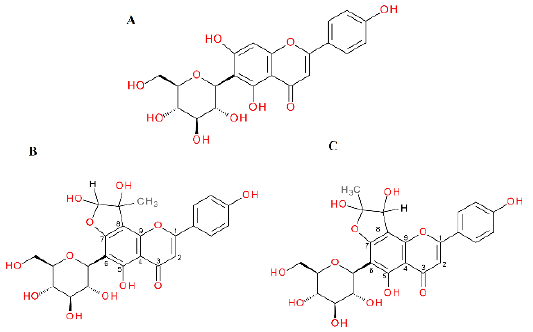
Figure 12. Proposals for chemical structures of adducts formed in the reaction of isovitexin with methylglyoxal after 1 h of incubation in pH 7.4 phosphate buffer solution at 37 °C; ( A ), isovitexin; ( B ), hemiacetal form of mono-MGO-isovitexin; ( C ) hemiketal form of mono-MGO-isovitexin. Other isomers are also possible.